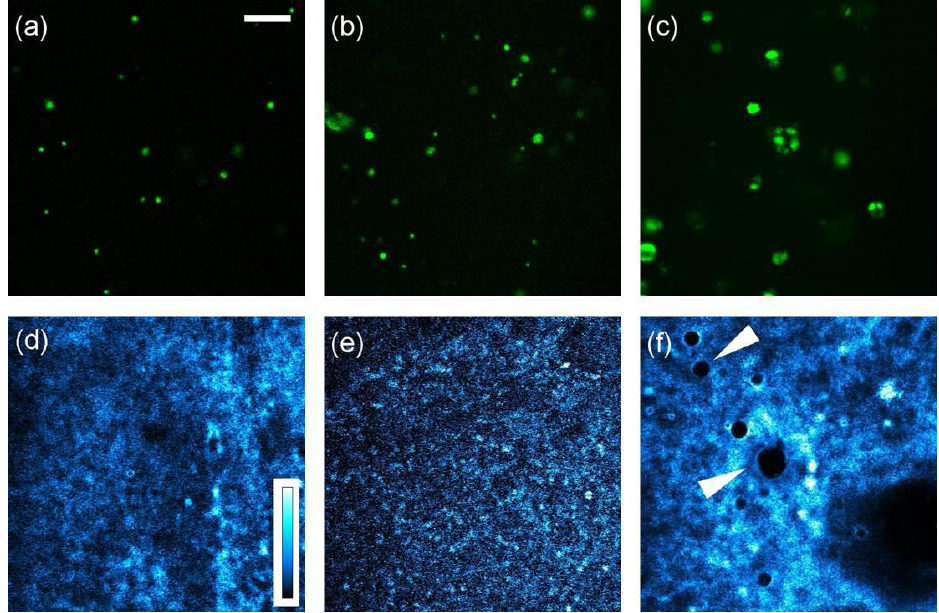
Fig. 4 Representative fluorescence (a–c) and SHG images (d–e) of tissue-engineered cartilage at high cell seeding density (2 × 10 6 cells/mL). SHG images are shown with the range between the maximum and the minimum intensity in each image to enhance the contrast. Images were acquired at 3 days (a, d), 8 days (b, e), and 15 days (c, f) after seeding. Scale bar = 100  m.